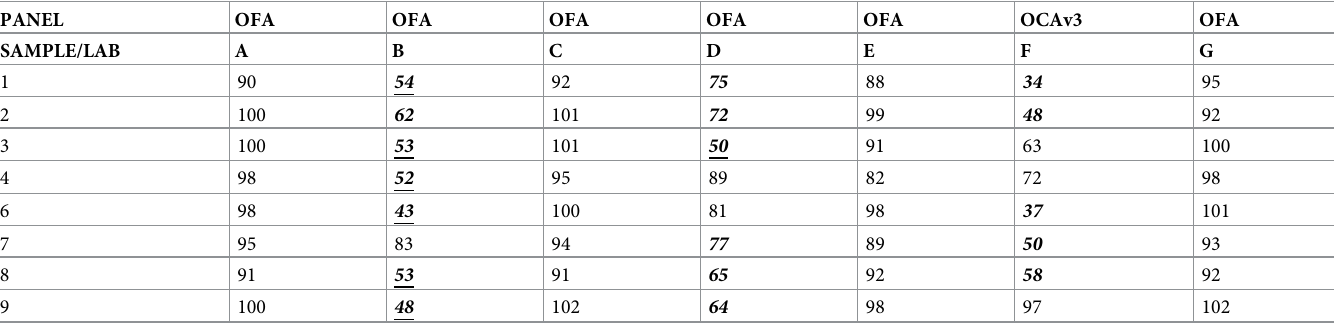
Table 10. Phase 2 RNA read length values.